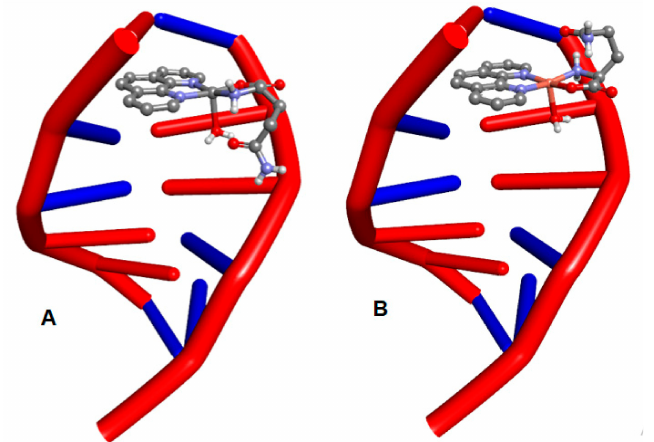
Figure 8. Docked structures of top molecular pose for: ( A ) anti-[Cu(L-Gln)(phen)(H 2 O]-151D and ( B ) syn-[Cu(L- Gln)(phen)(H 2